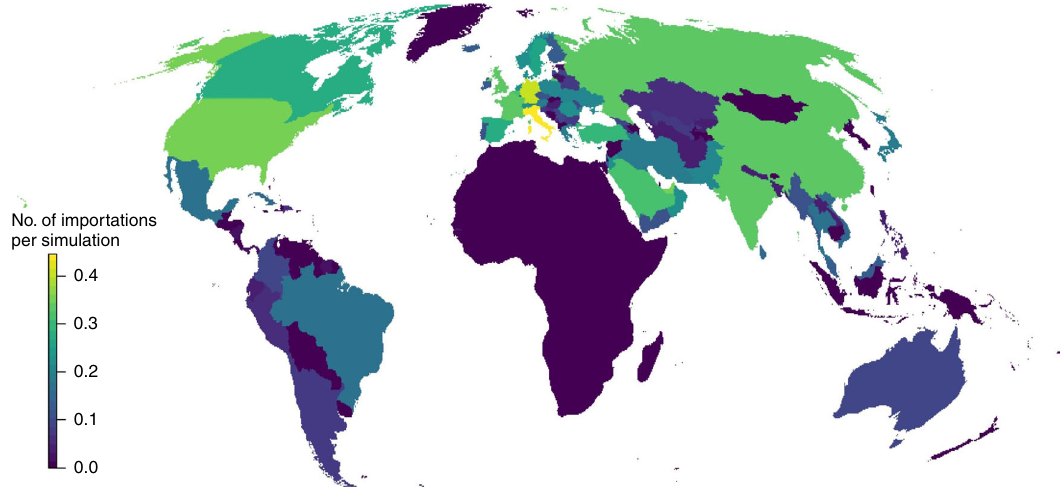
Fig. 4 Most common country locations for importation of EBOV infected individuals. Map shows the number of importations per simulation that countries outside Africa received via airline fl ights. Countries with the most EBOV infected individuals imported are represented in yellow with darker green, then blue, coloured countries having proportional fewer importations and dark blue showing zero importations and the EVD endemic area. Data come from 2500 simulations of EVD outbreaks under present data climate, land-use, demographic and transportation conditions